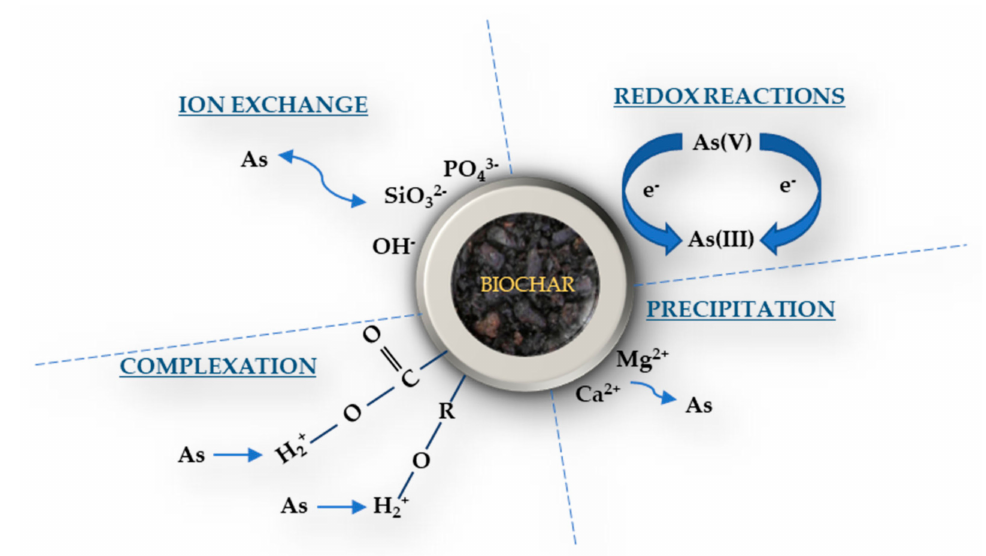
Figure 5. Potential mechanisms of biochar interactions with As in soil (modified from